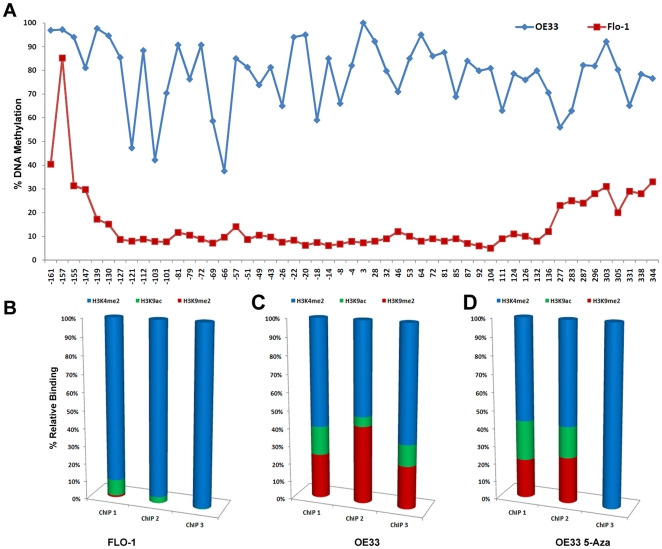
Quantitative Chromatin Immunoprecipitation (ChIP) assay of the MT3 promoter.The three ChIP assays of the MT3 promoter are shown in Figure 1A and Table 1. All ChIP experiments were performed in triplicates for each assay. Following quantitative real-time PCR (qPCR), the percent of relative of DNA binding in B, C and D was determined by normalizing the indicated histone binding level to its corresponding input and H3 levels. A relative percent of occupancy of three histones is shown. A) DNA methylation levels in the CpG nucleotides from −161 to +344 in OE33 and FLO-1 cell lines demonstrate a lower methylation level in FLO-1 cells. B) ChIP-qPCR in FLO-1 cells, demonstrate relatively low levels of repressive histone H3K9me2 as compared to histone H3K4me2 and H3K9ace. C) ChIP-qPCR results in the OE33 cell line show high levels of H3K9me2 as compared to the other two histones. D) ChIP-qPCR results in OE33 cell line, following administration of 5 µM 5-Aza for 72 h, reversed the relative abundance of the histone modifications towards active expression.